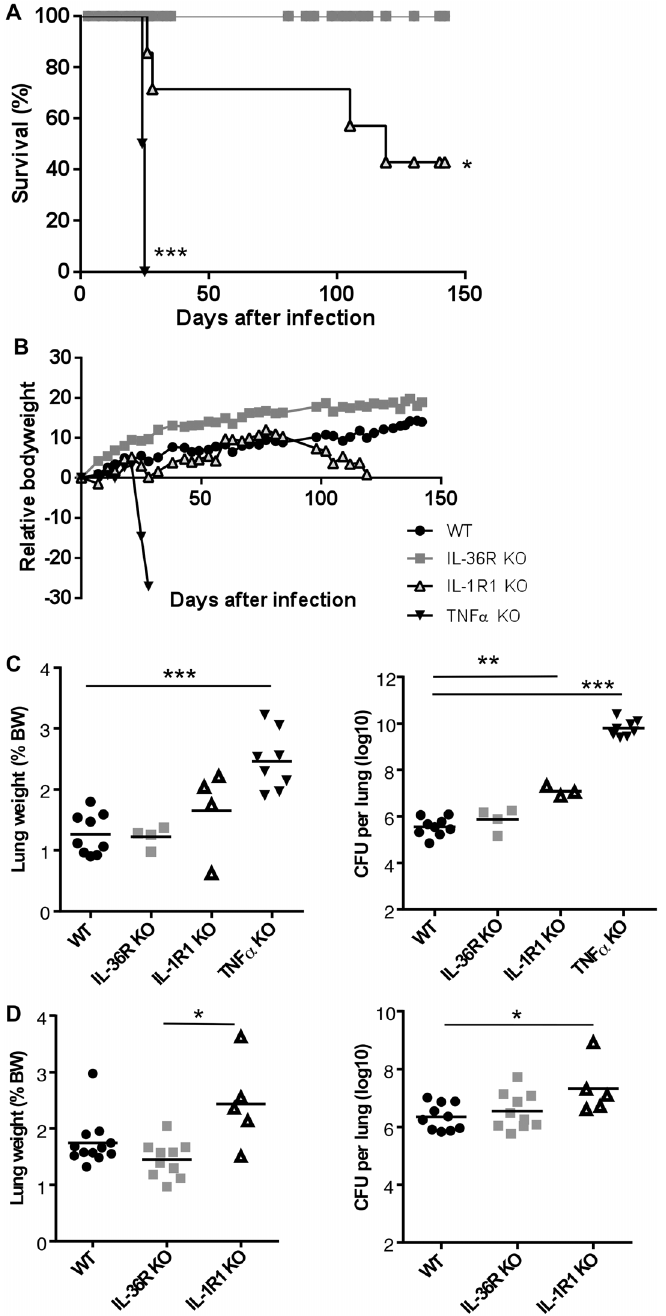
Fig 8. IL-36R is dispensable to control acute M . tuberculosis infection. Mice deficient for IL-36R, IL-1R1 or TNF- α , and WT mice were exposed to an aerogenic dose of M . tuberculosis H37Rv and monitored for survival (A) and body weight. The results represent mean body weight ± SEM values of 8 – 14 mice per group, pooled from 2 independent experiments. Lung weight (left panels) and bacterial loads (right panels) were determined in TNF- α deficient, IL-36R deficient, IL-1R1 deficient, and WT mice at 1 month (C) and 4 months (D) post infection. Results are expressed as individual values and mean (n = 4 – 9 for lung weight, n = 3 – 9 for CFU) from 1 experiment at 1 month and (n = 5 – 12 for lung weight, n = 5 – 10 for CFU) from 2 experiments at 4 months. * P < 0.05, ** P < 0.01, *** P < 0.001 as compared to the wild-type controls (assessed by Kruskal- Wallis, followed by Mann-Whitney